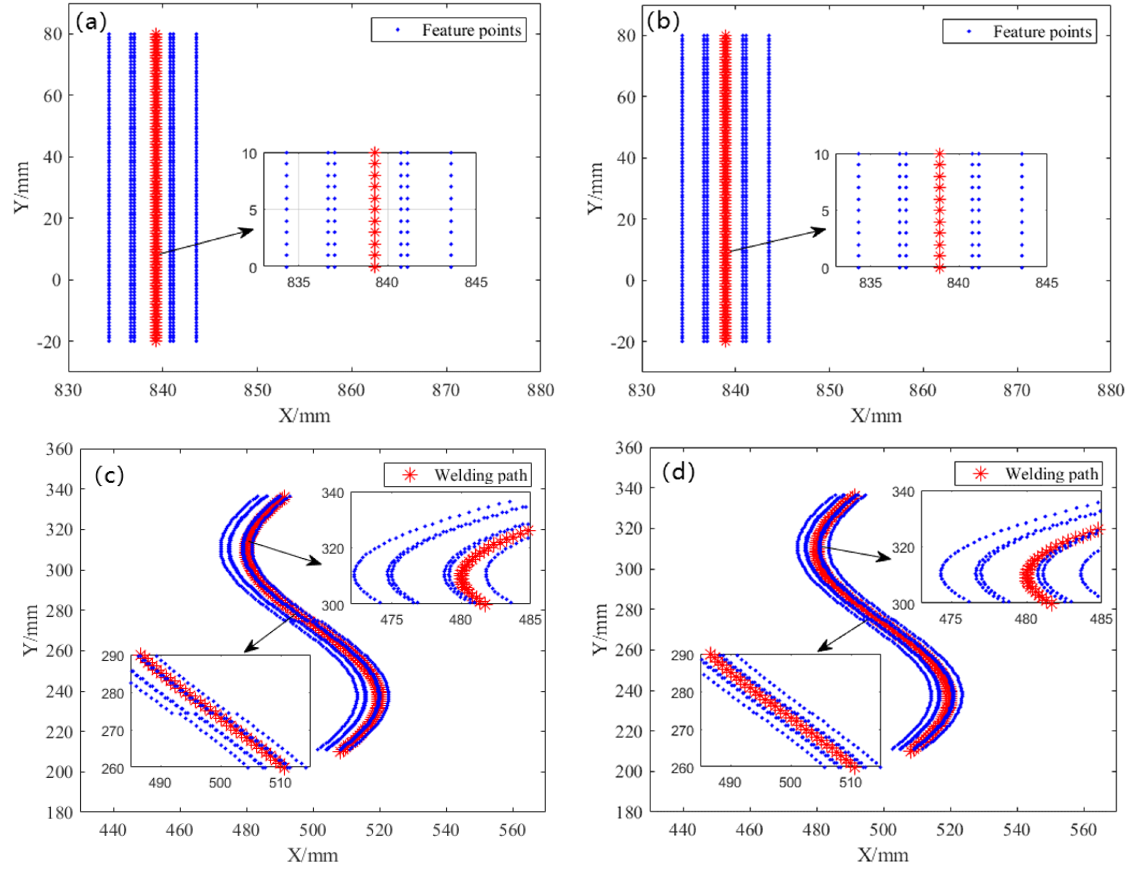
Figure 12. Experimental results of ( a ) straight line with initial positioning; ( b ) straight line with precise positioning; ( c ) curve with initial positioning; and ( d ) curve with precise positioning.